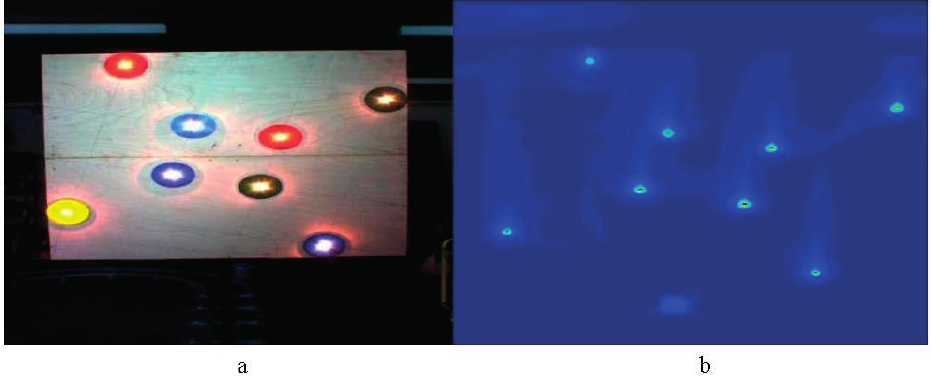
Figure 1. Same scene acquired by different sensors. ( a ) Image from RGB camera; ( b ) Image from thermal